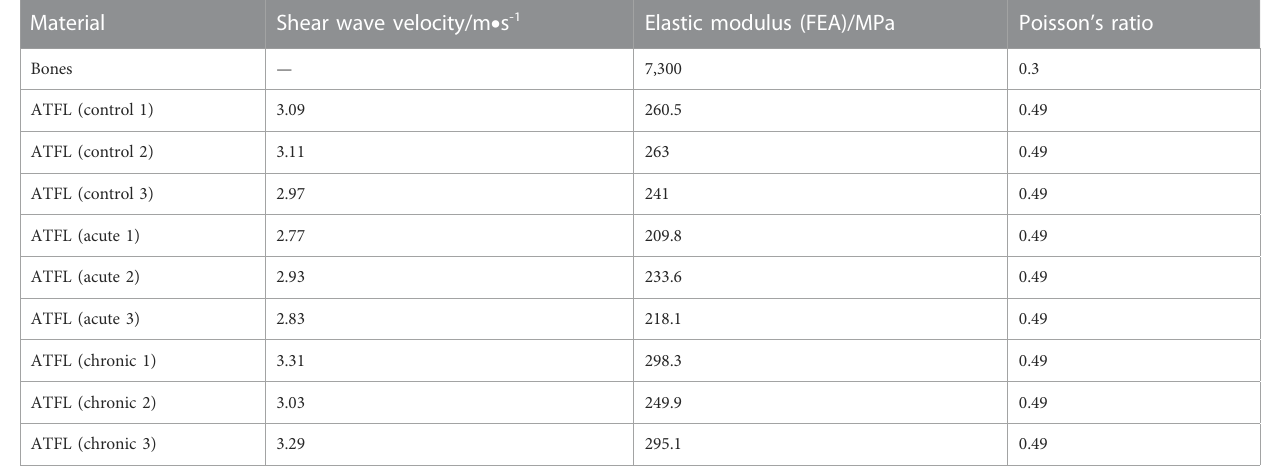
ATFL, anterior talo fi bular ligament.